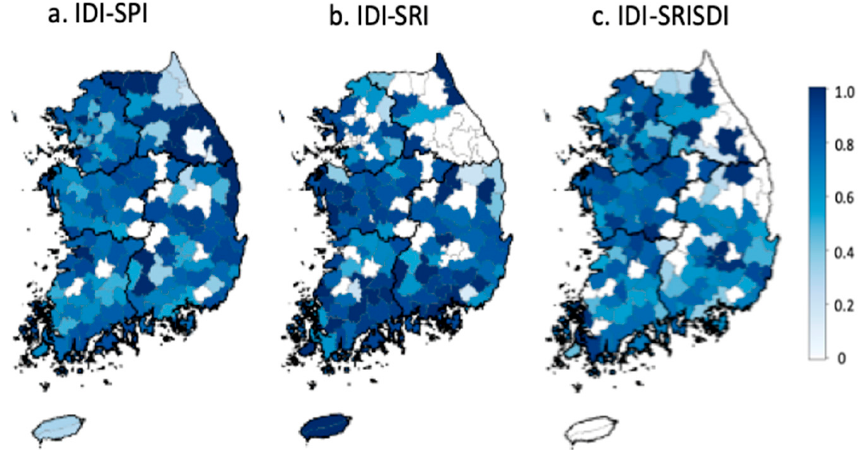
Figure 6. Results of correlation analysis for the application of the integrated drought index.